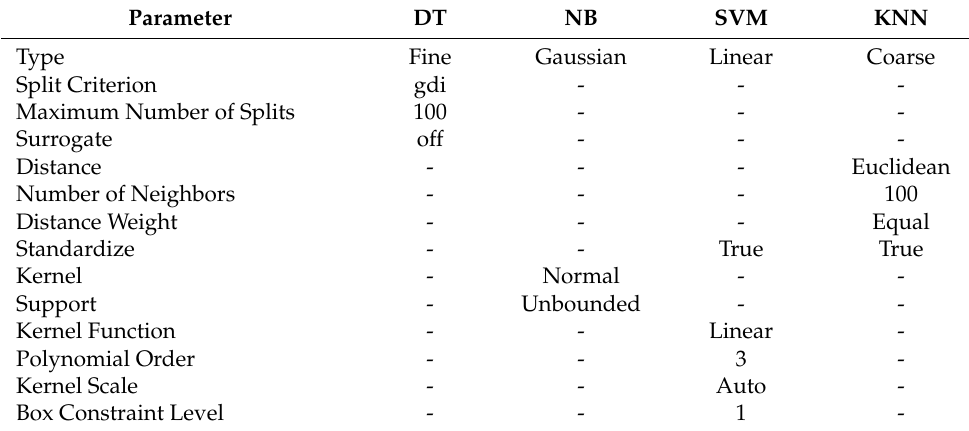
Table 2. Parameters of classification algorithms used in the proposed method.